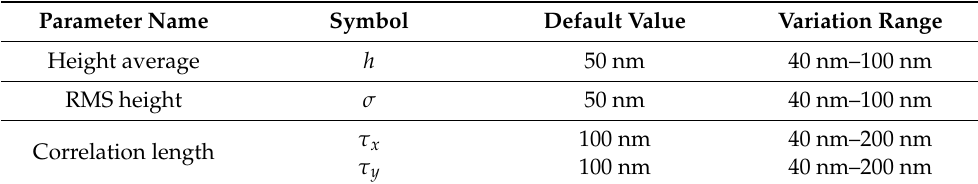
Table 2. Default values of random rough surface parameters.